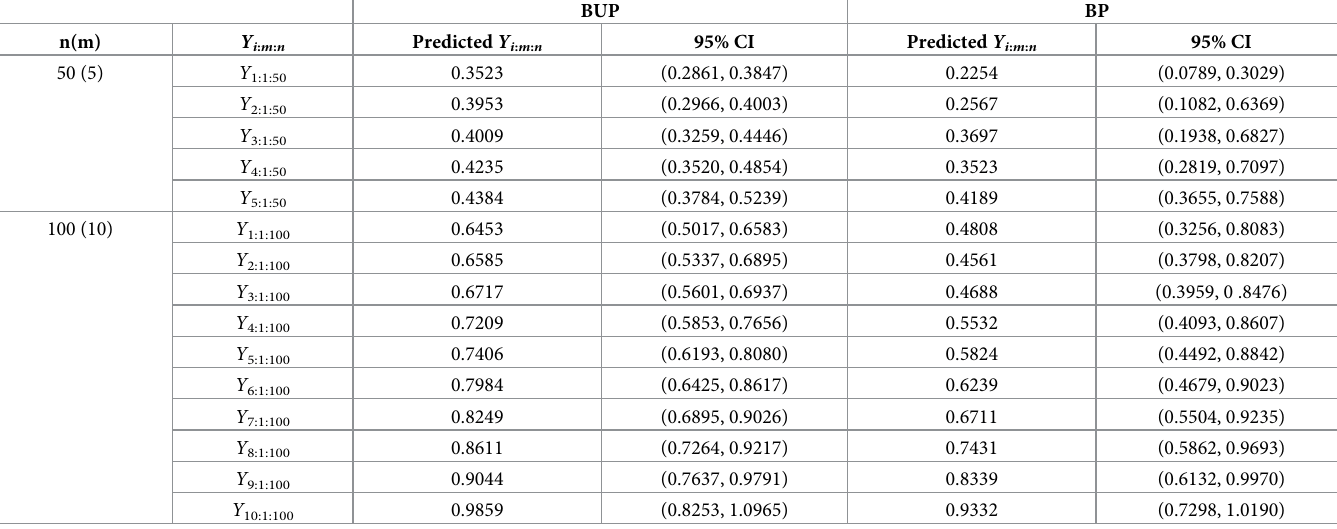
Table 6. Point and interval prediction of the unobserved order statistics Y